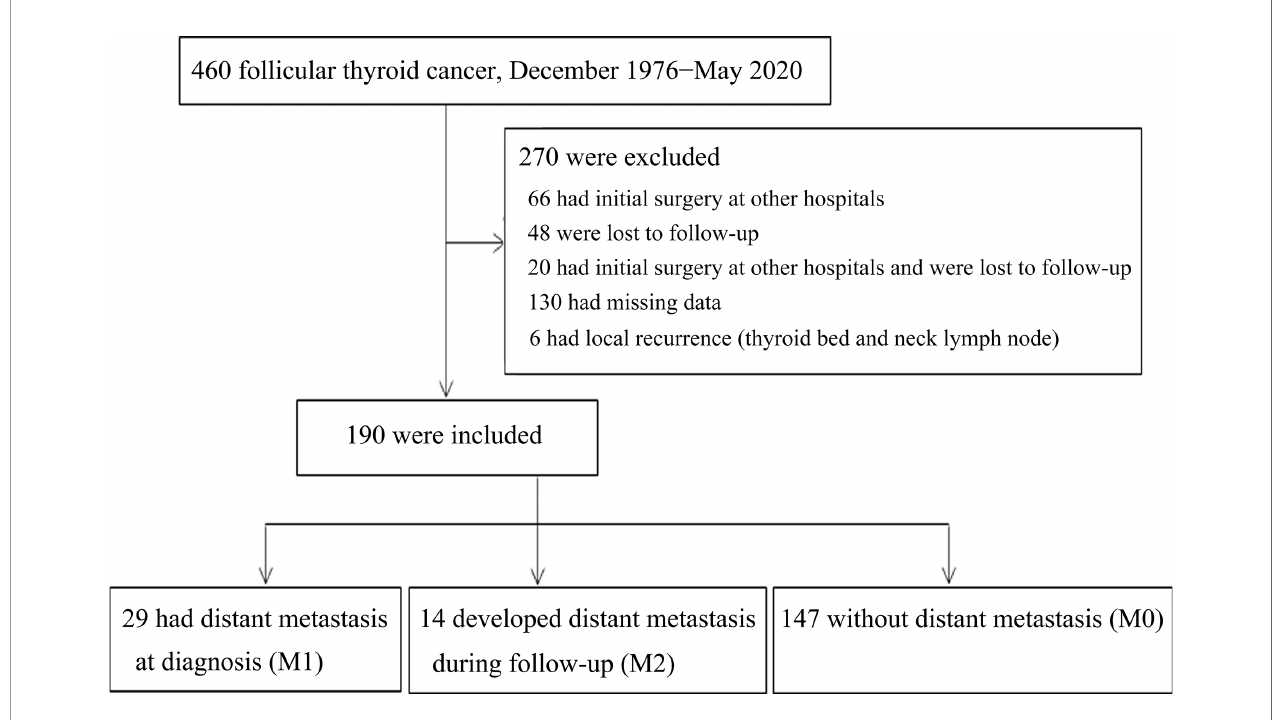
FIGURE 1 | Flowchart of cohort